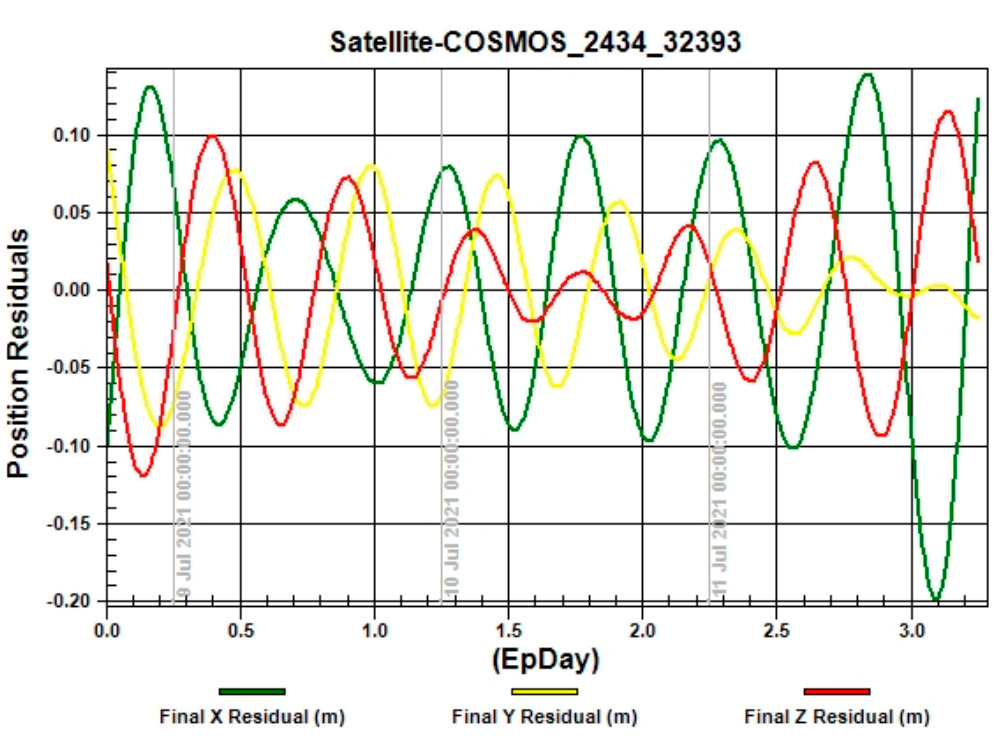
Figure 6. The relationship between the position residuals and the time for satellite “COSMOS-2434”.